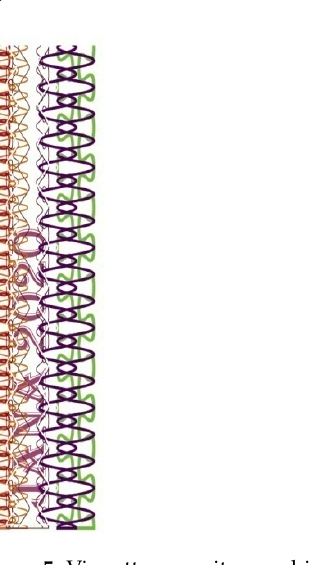
Figure 4. En face. Figure 4. En face.